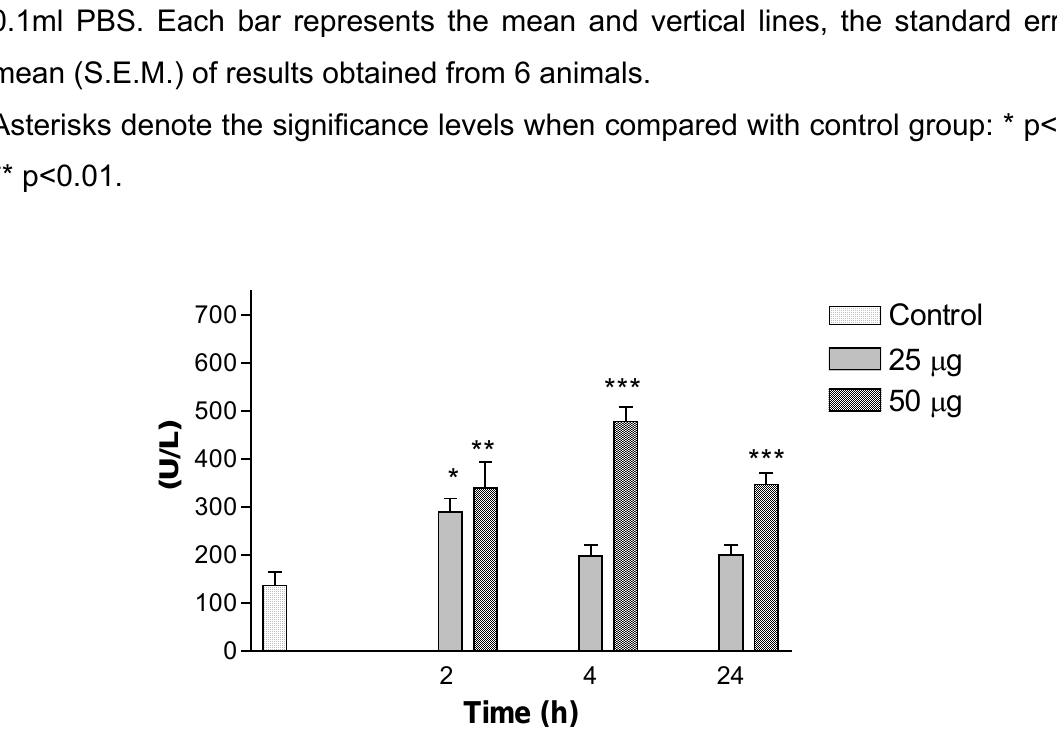
Figure 3: Variations in lactate dehydrogenase (LDH) levels in mice intraperitoneally injected with 25 or 50 μ g of Bothrops jararacussu venom diluted with 0.1ml PBS. Each bar represents the mean and vertical lines, the standard error of mean (S.E.M.) of results obtained from 6